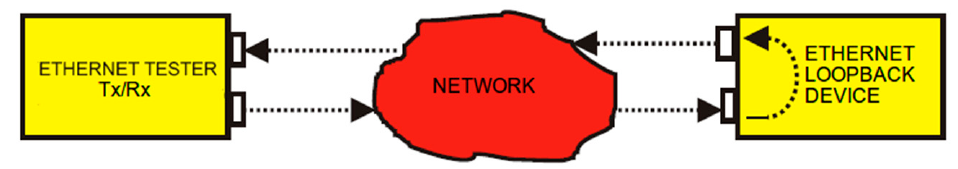
Figure 4. Logical loop-back aided end-to-end testing.